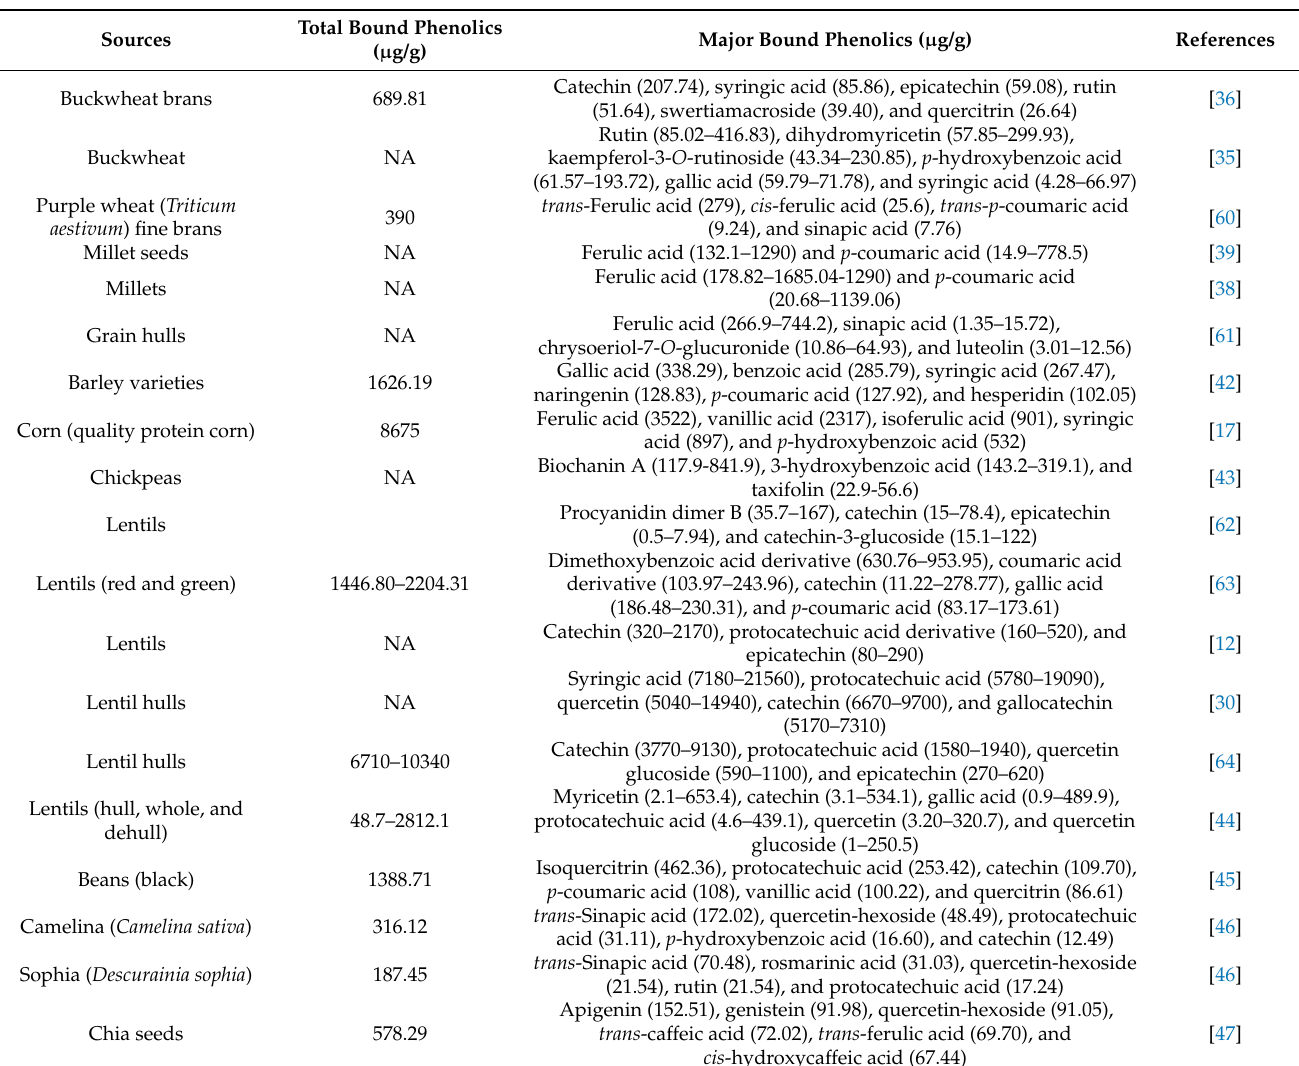
Table 3. Individual phenolic compounds in various food